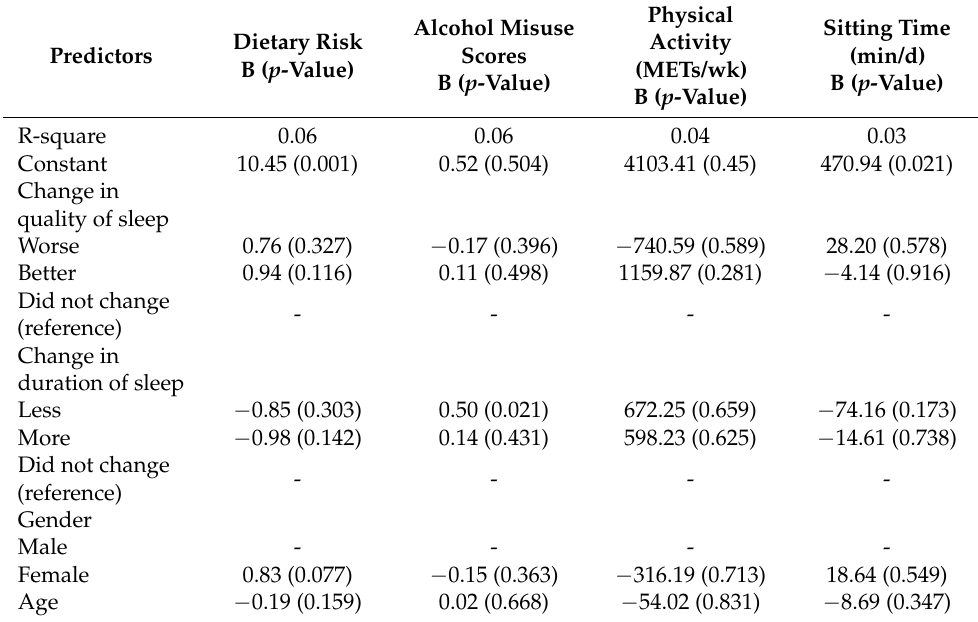
Table 6. Linear regression models exploring sleep alteration linked to health